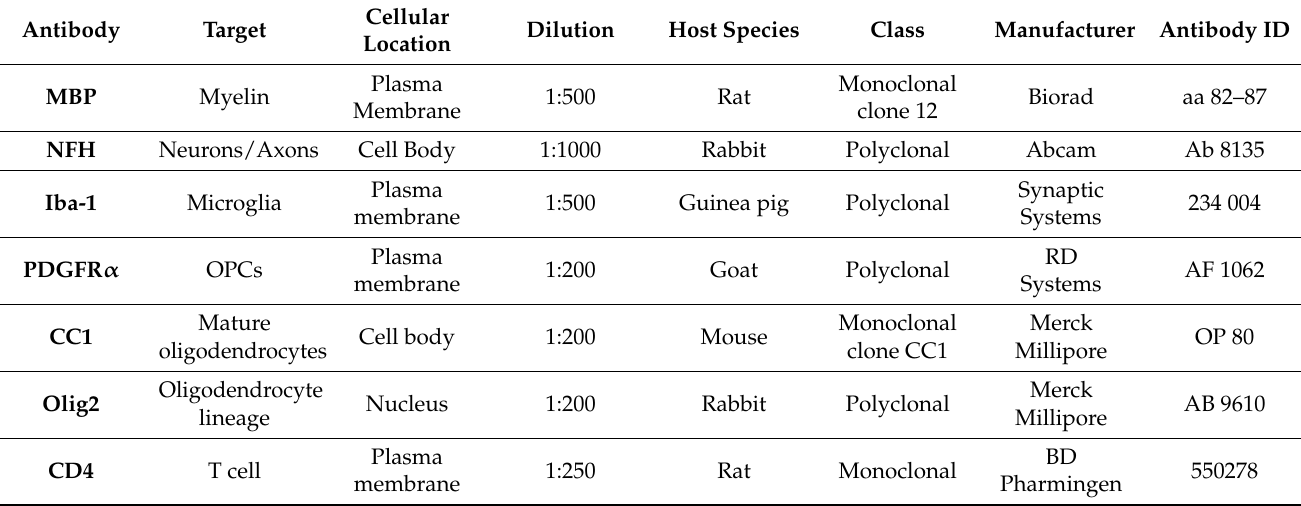
Table 1. List of antibodies used in this